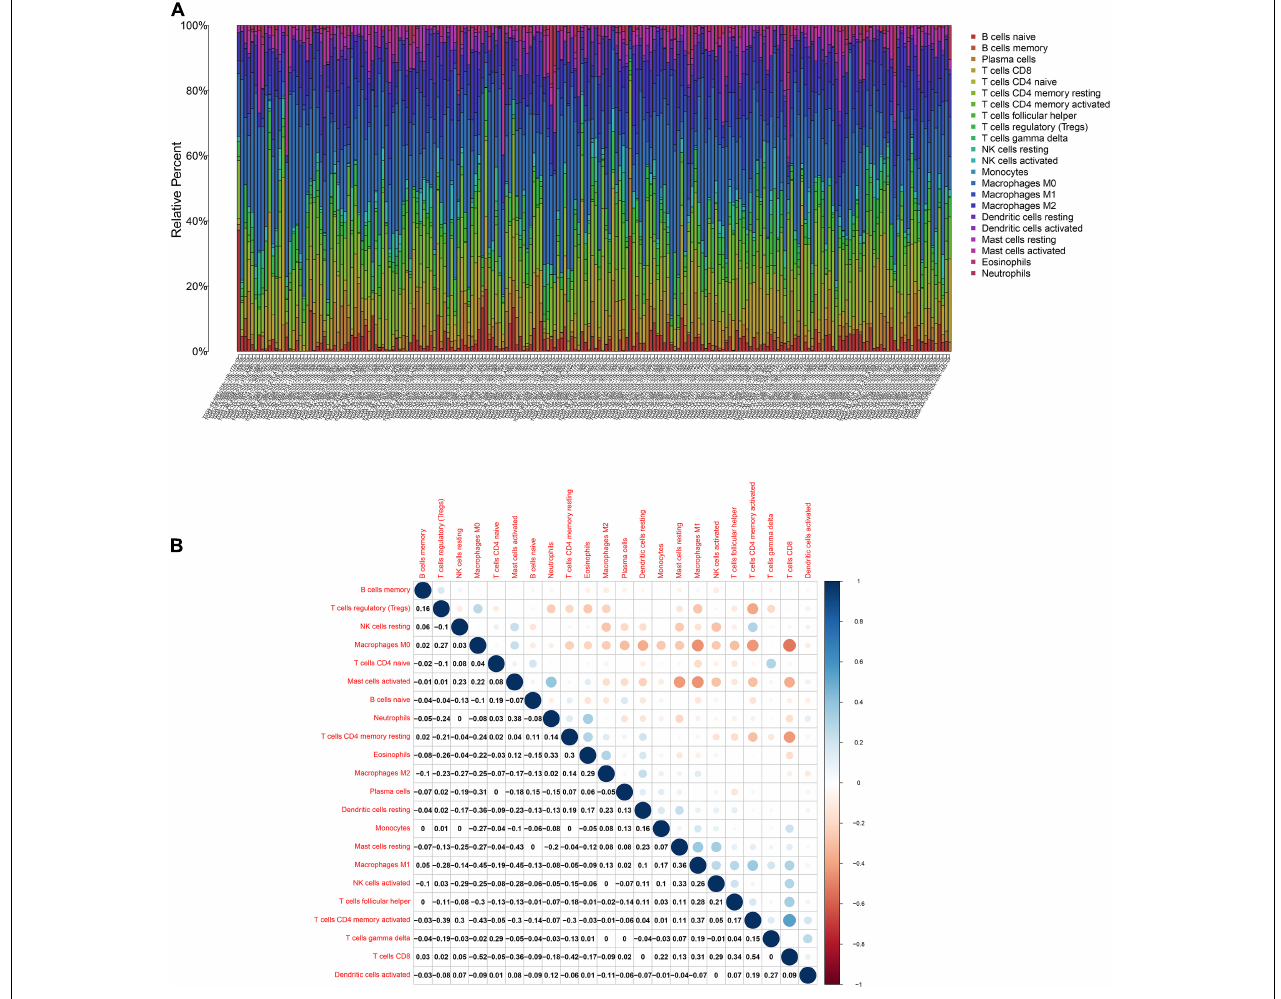
FIGURE 7 | TIC profile. (A) Barplot displays the ratio of 22 kinds of TICs in colon cancer samples. Column names: sample ID. (B) Heatmap displays the association between 22 kinds of TICs; each spot represents the p -value of correlation between two kinds of cells; Pearson coefficient was carried out for significance test.